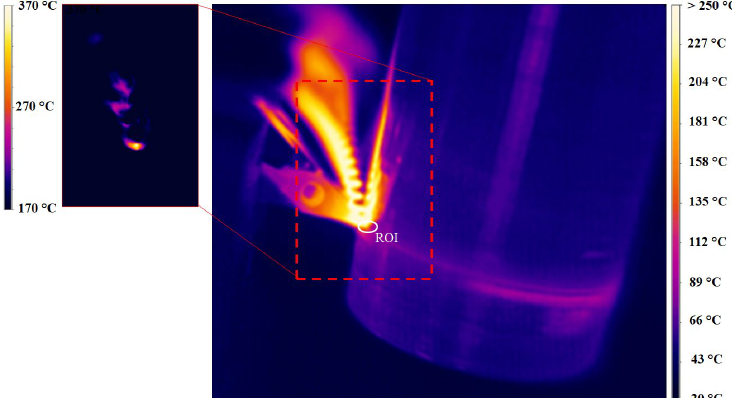
Figure 6. Example of a thermographic image captured during the cutting process (with thermal map artifacts due to the light reflection from the chip). The figure also shows the oval-shaped ROI used for the temperature measurements. Table 6. ANOVA results for cutting temperature. Dof: degree of freedom.